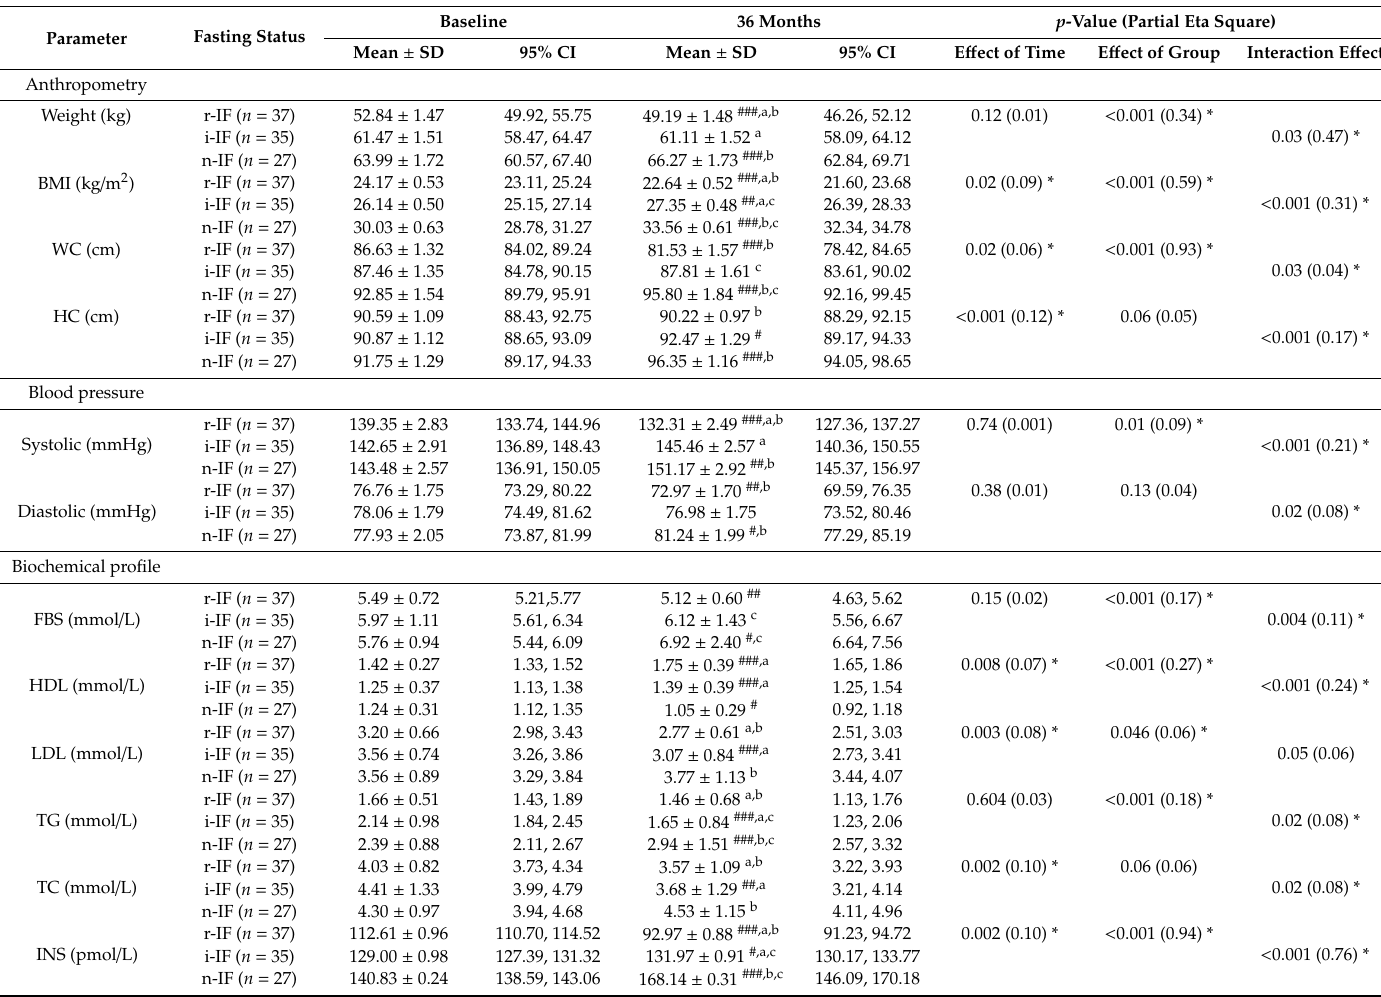
Table 2. Comparison of anthropometry profiles, blood pressure, biochemical profiles, and cognitive test performance among three di ff erent intermittent fasting (IF) status groups on the basis of time (time*treatment interaction e ff